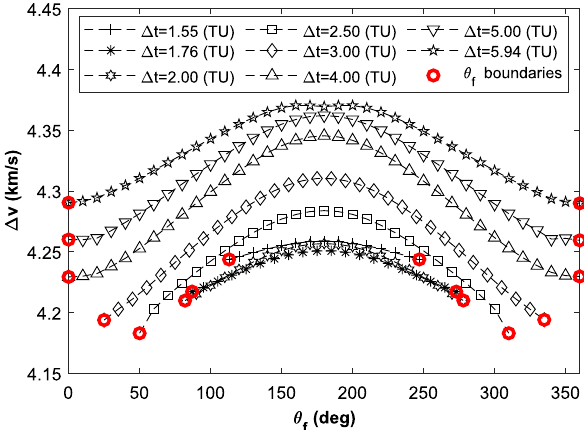
Figure 14. Inclination changeable capacity in the spatial CR3BP.